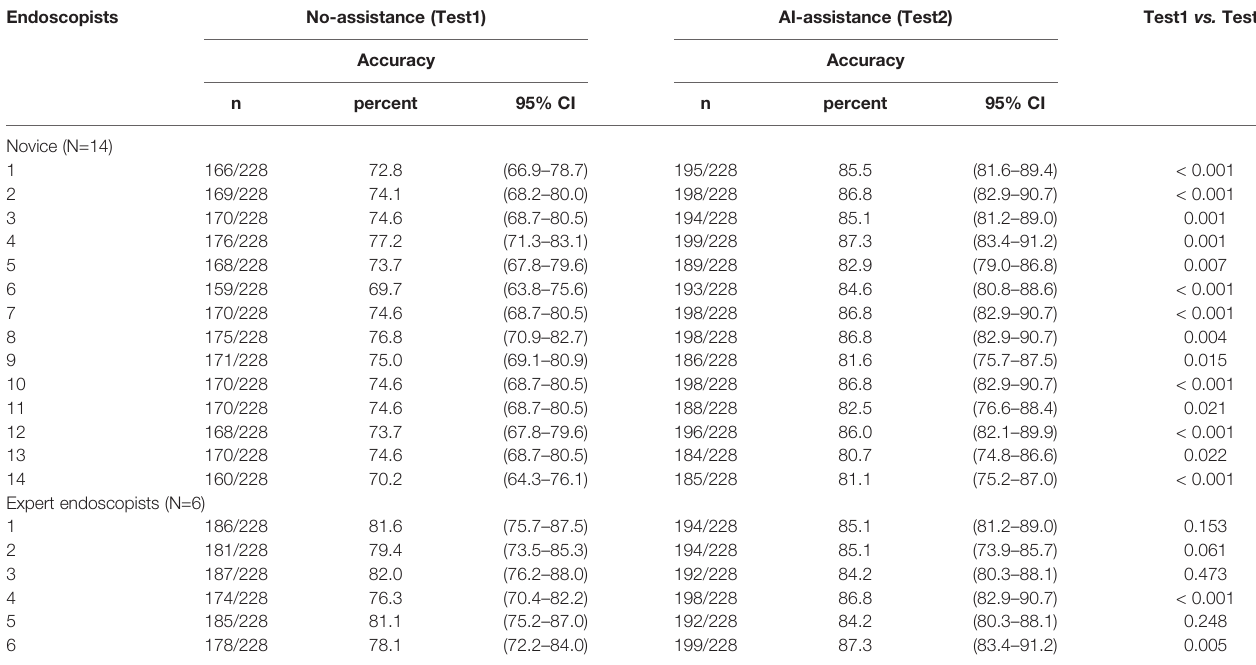
TABLE 2 | Diagnostic Accuracy of Endoscopists with or without the Assistance of DCNN Model. Endoscopists No-assistance (Test1) AI-assistance (Test2) Test1 vs.